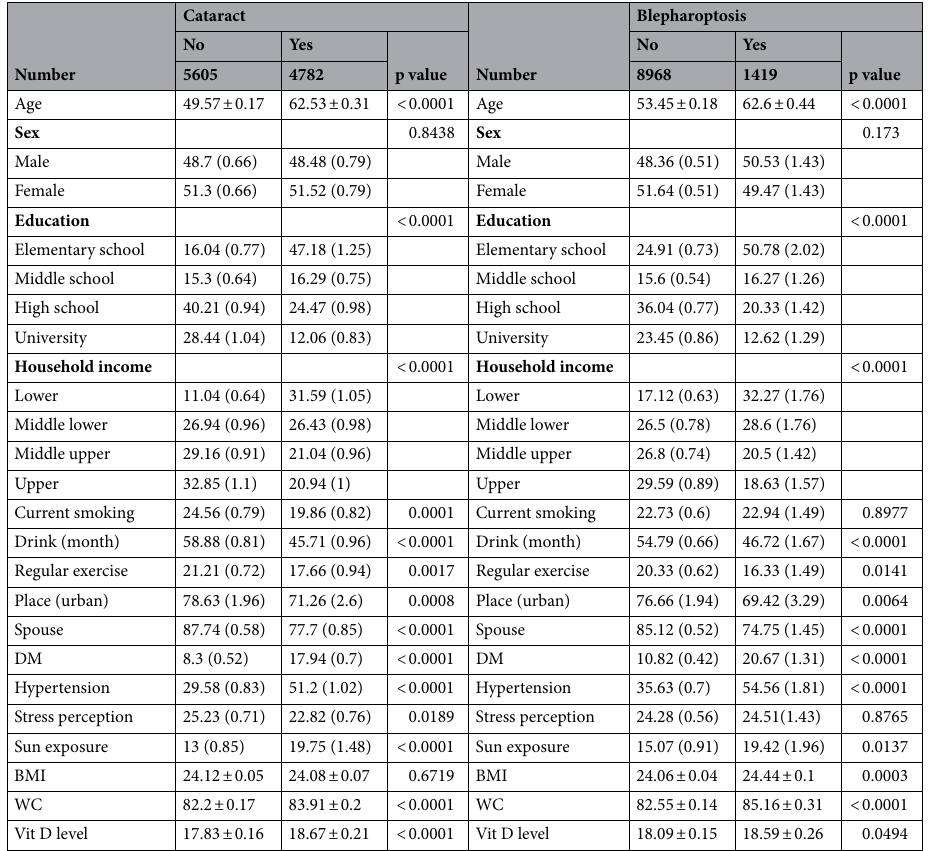
Table 1. General characteristics of study participants. Geometric means/Values are presented as measn (SD) for continuous variable and n (%) for categorical variables. DM diabetes mellitus, BMI body mass index, WC waist circumference, Vit D vitamin